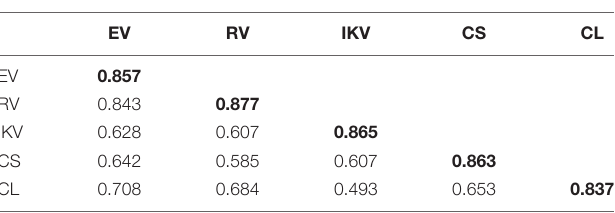
TABLE 7 | Inter-variable correlations. FIGURE 3 | Structural model.